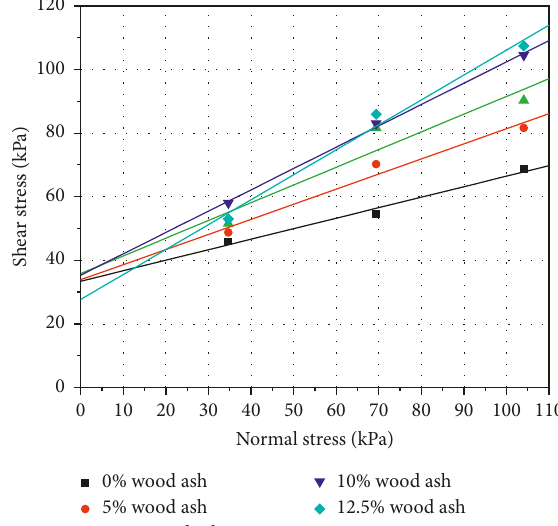
Figure 8: Plot of the void ratio, e , versus effective stress, σ .